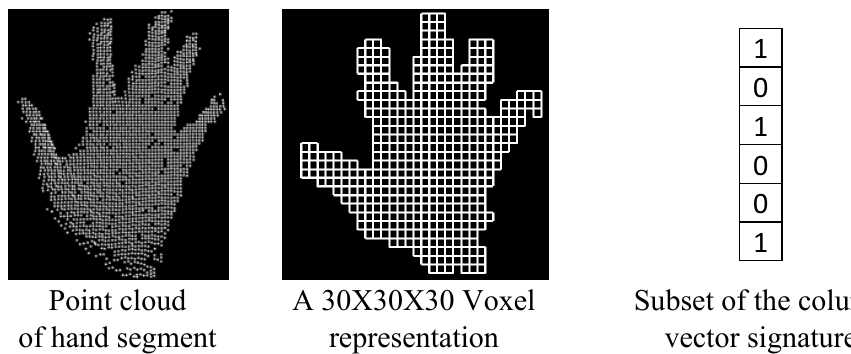
Figure 9. Generation of a hand segment